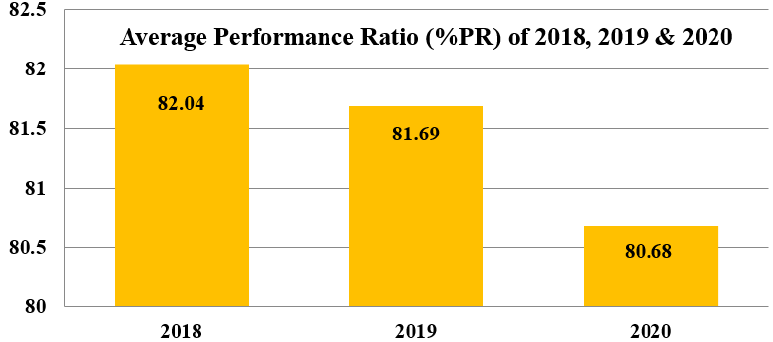
Figure 9. Comparison of PR in 2018, 2019, and 2020 of 467.2 kWp Plant (P 1 + P 2 + P 3 ).